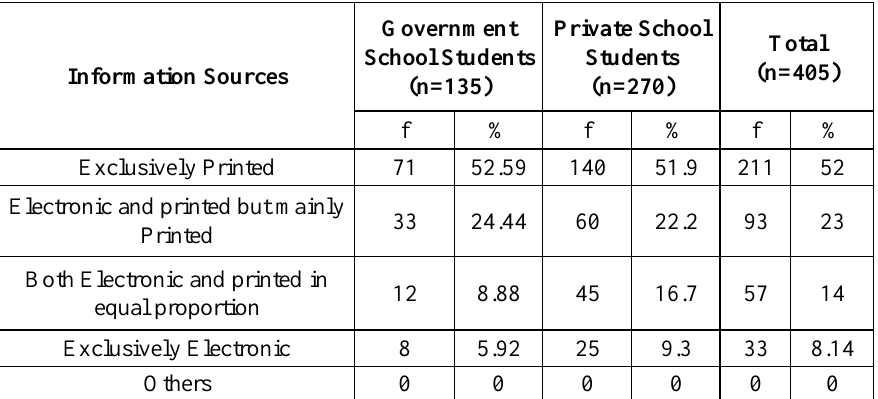
Table 2- Preference for Printed V/s Electronic Resources for Information